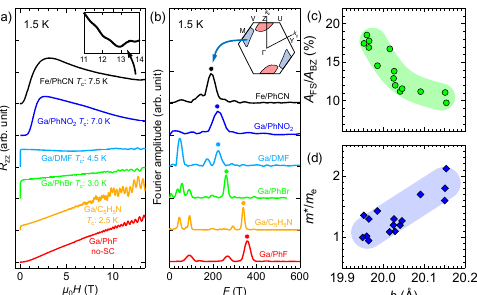
Figure 3. ( a ) Magnetoresistance of some salts at 1.5 K [41]. Each dataset has an offset for clarity. The inset is an enlarged plot for Fe/PhCN to highlight the quantum oscillations. ( b ) Fourier spectra of the SdH oscillations shown in ( a ). The peaks marked with the circles originate from the electron Fermi pocket around the M point shown in the inset. ( c , d ) Ratio of the size of the electron Fermi pocket A FS and the Brillouin zone A BZ ( c ) and the effective mass ( d ) as a function of the b -axis length. These results were reported in Refs.